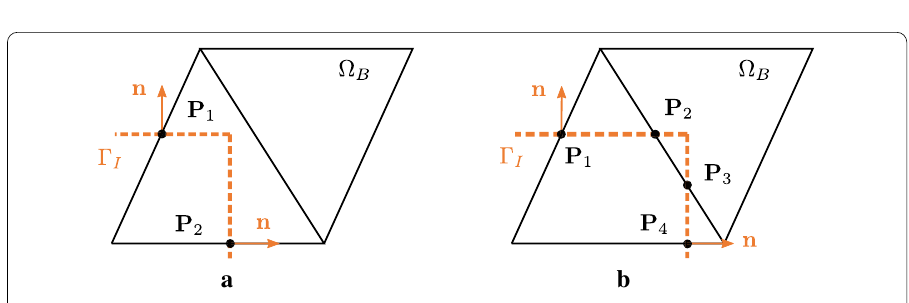
a b Fig. 16 Conceptual illustration of intersection patterns with sharp edges inside single background elements. a Case: intersection points uniquely define a plane. b Case: approximation by a plane requires fitting